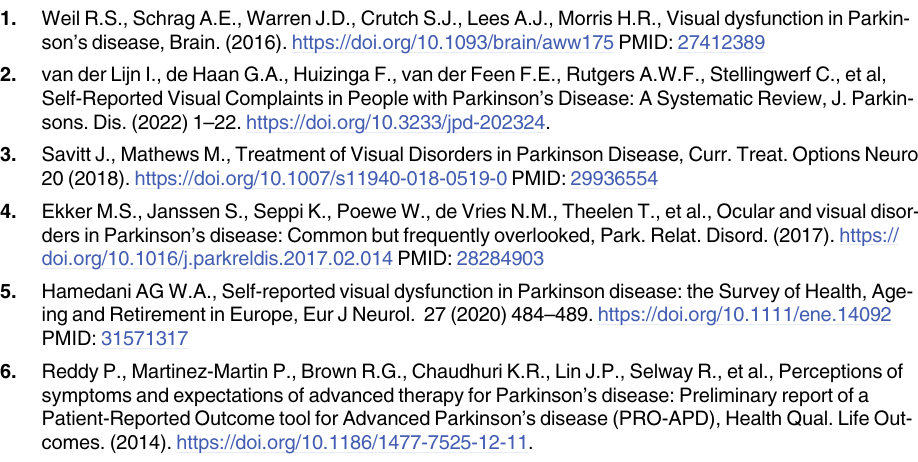
S3 Table. Screening visual complaints questionnaire–English version.